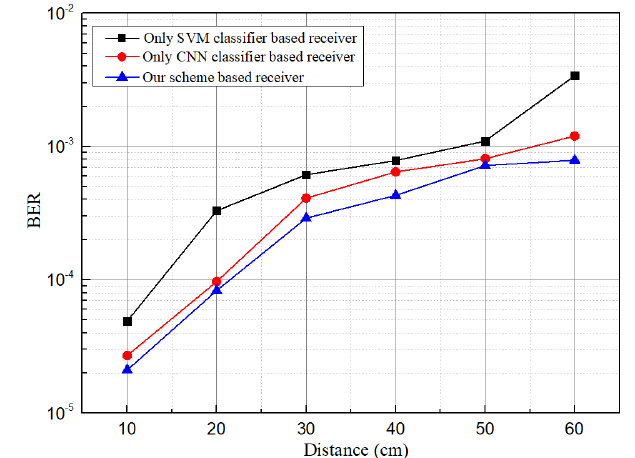
Figure 10. Comparison of bit error rate (BER) among receivers using only SVM, only CNN, and our proposed